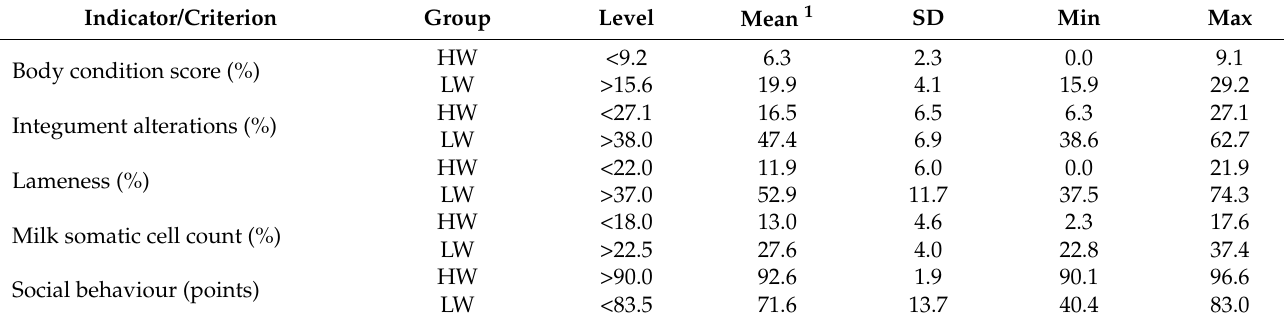
Table 3. Classification of groups with high animal welfare (HW; upper tertile) and low animal welfare (LW; lower tertile) within specific animal welfare indicators or criterion (body condition score, integument alterations, lameness, milk somatic cell count, and social behaviour); levels = thresholds for upper and lower